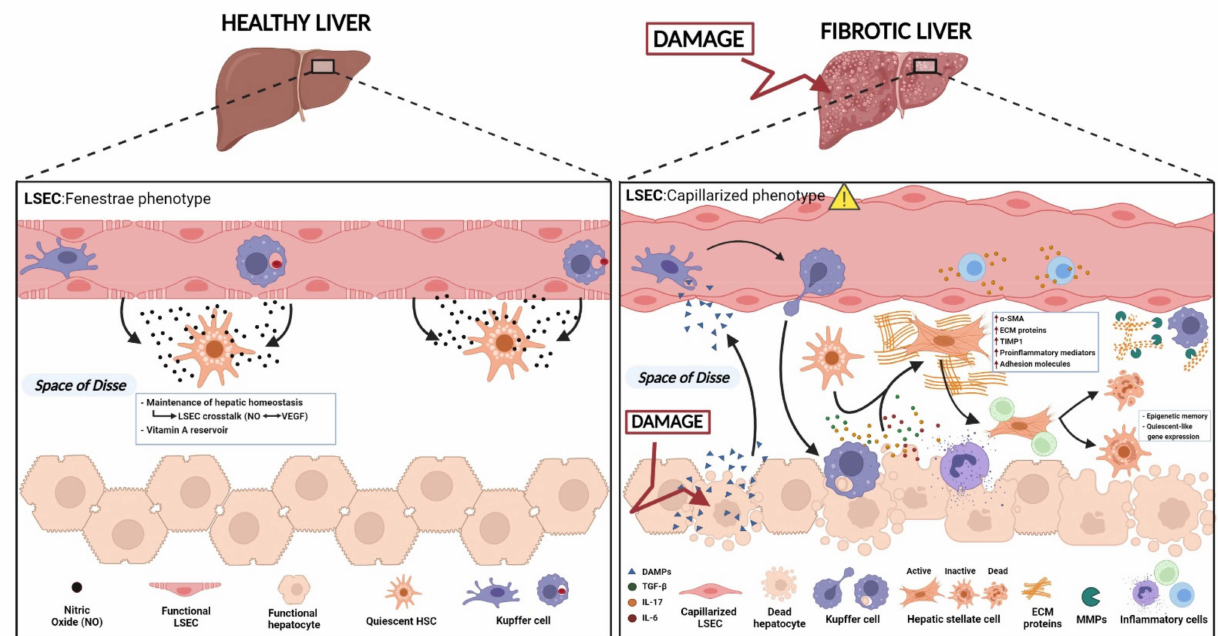
Figure 1. Progression of hepatic fibrosis. Under physiological conditions, HSCs are found in a quiescent state where they function as pericytes and reservoirs of retinol (vitamin A). Retinol, together with other lipids, is stored in perinuclear cytoplasmic lipid droplets. Liver sinusoidal endothelial cells (LSECs) retain HSCs quiescent state by the releasing of nitric oxide (NO). When the liver is injured, HSCs transdifferentiate into a myofibroblast-like cell with a high proliferative and secretory phenotype. This occurs as a consequence of different factors. Firstly, LSECs change their phenotype into a capillarized structure while stopping the release of NO. Damaged hepatocytes release damage-associated molecular patterns (DAMPs) that attract and activate Kupffer cells and other inflammatory cells. These macrophages go to the injury site and release pro-inflammatory and pro-fibrogenic cytokines such as TGF-B, IL-17, and IL-6, inducing the activation of HSCs. In this activated state, HSCs acquire a high proliferative, secretory phenotype, where the perinuclear lipid droplets are lost and high levels of alpha smooth muscle actin ( α -SMA) are transcribed in an attempt to help the cell migrate to the site of injury. Together with ECM molecules, the activated HSCs secrete molecules of tissue inhibitor of metalloproteinase-1 (TIMP1) to control matrix degradation. Cytokines and growth factors that help to repair injured liver tissue, as well as different pro-inflammatory mediators and adhesion molecules are secreted to recruit resident and circulating immune cells, thus further contributing to the perpetuation of fibrosis. The figure was created with